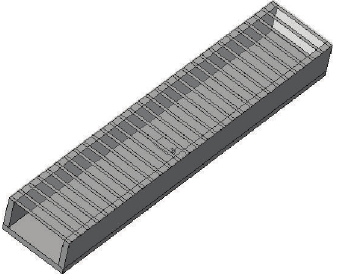
Figure 4: Prototype of the sectoral